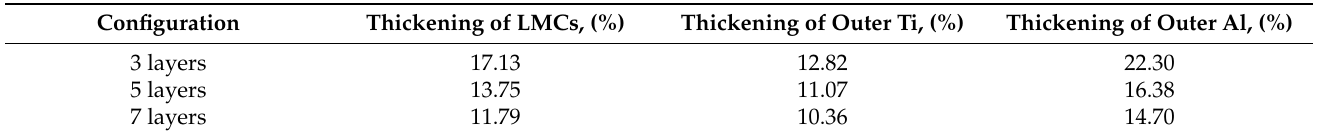
Table 3. The thickening ratio of the deep-drawing parts of LMCs with different layers at the wall section of 50 mm from the bottom